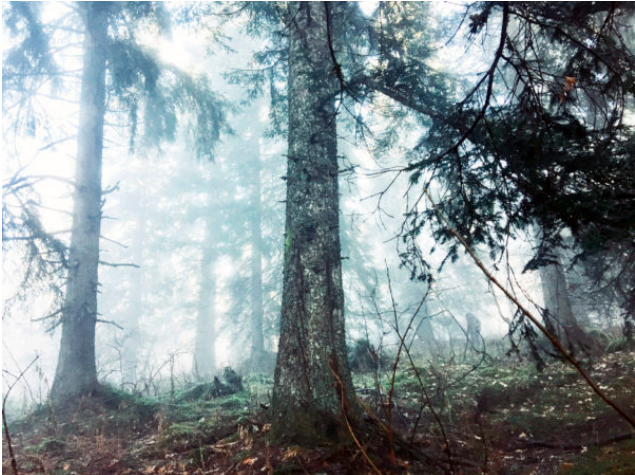
Figure 1. Photo from https://www.ceuxdici.ch/jeux-de-la-balle/ (reprinted with permission from Carine Roth (2020) accessed on 3 November